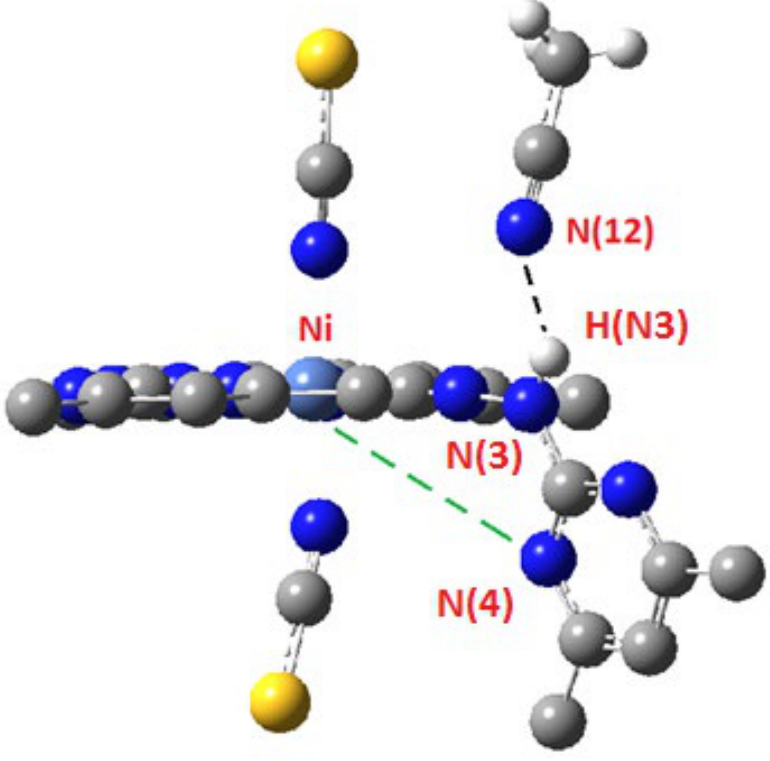
Figure 5. Intermolecular hydrogen bond between the nitrogen atom of the acetonitrile molecule and the hetarylhydrazone moiety of compound 4 .